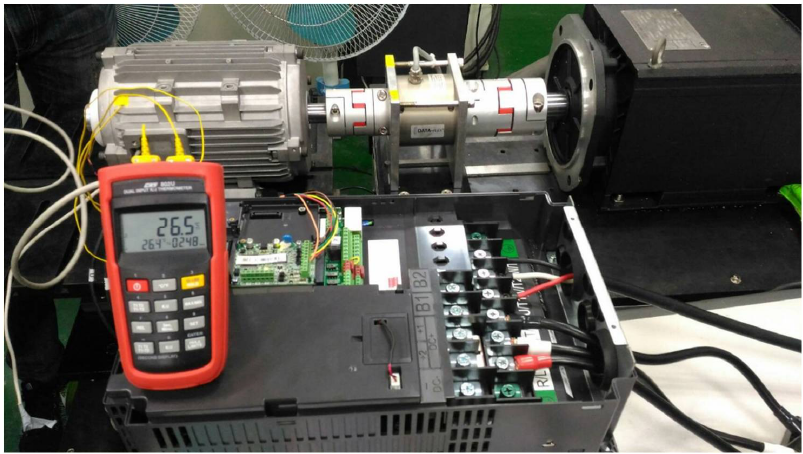
Figure 26. Temperature measurement setup for the double layer IPMSM.